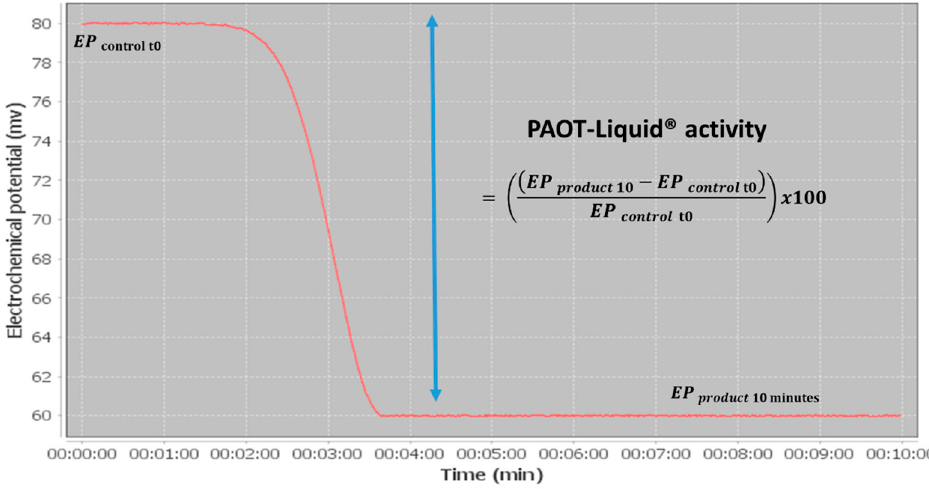
Figure 2. Kinetic curve of electrochemical potential changes during reaction of antioxidants or wines samples with the free radical mediator M • .